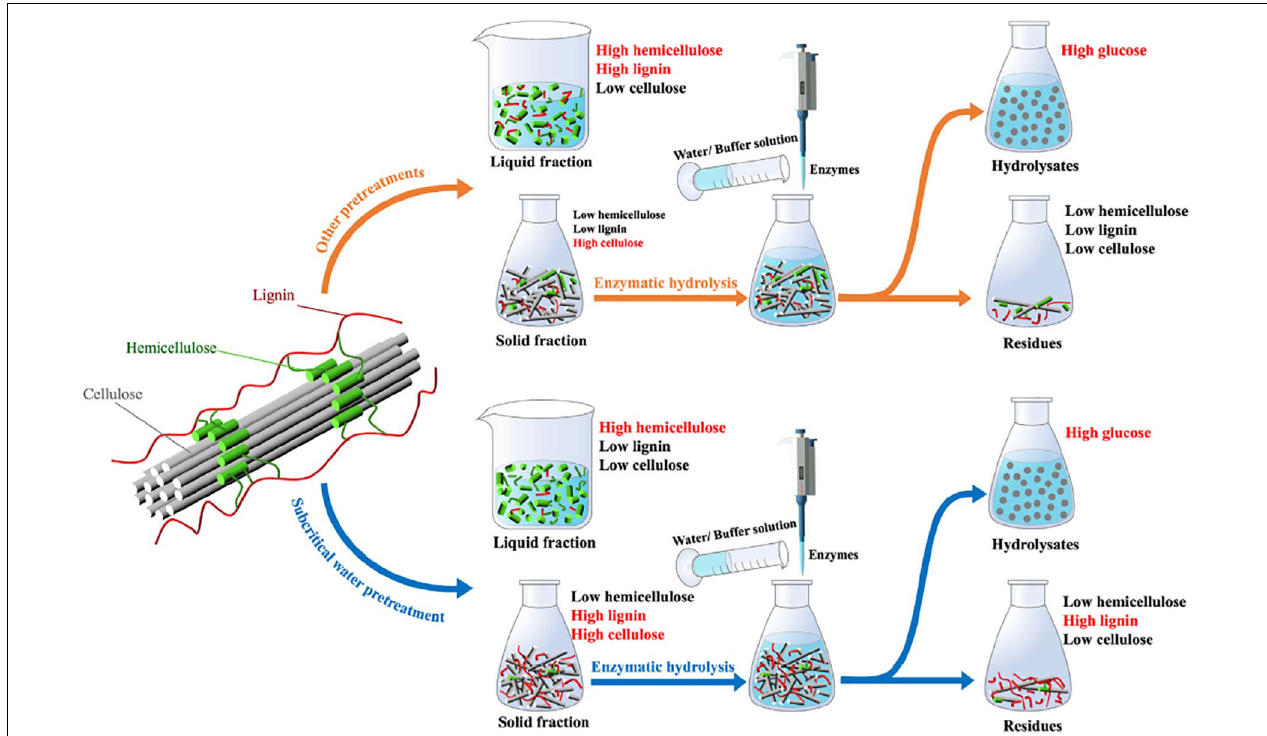
FIGURE 1 | Different variations of lignin and cellulose content between subcritical water pretreatment and other pretreatments (Chen et al.,